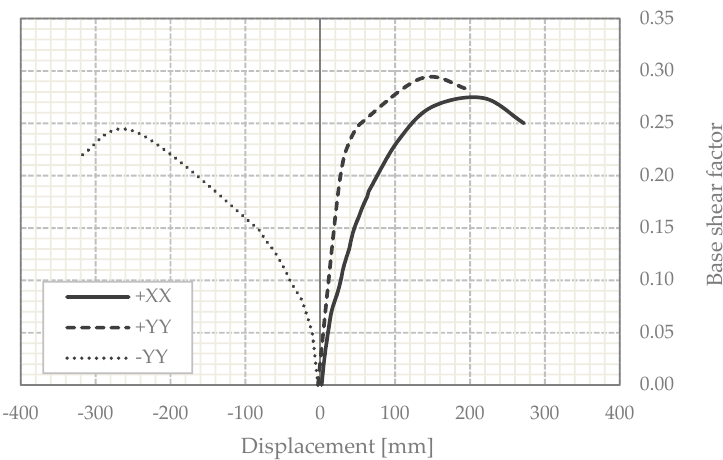
Figure 10. Capacity curves for nonlinear static analyses. Control point at the top of the south tower. The base shear factor corresponds to the ratio between the sum of the horizontal forces and the total self-weight of the structure [dimensionless].